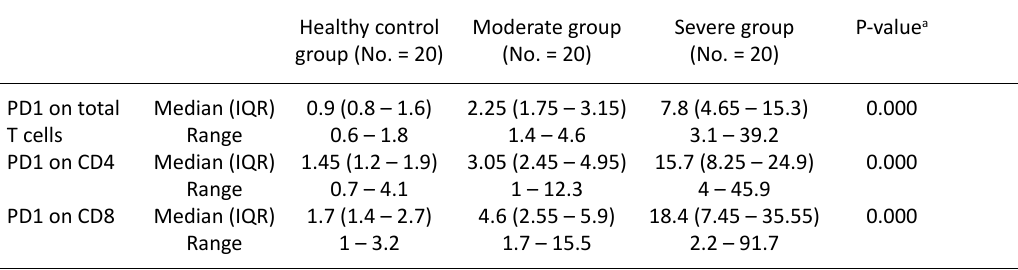
Fig. 1. Comparison between the healthy control group, moderate group and severe group regarding IL-10 serum level revealing a higher level in patient groups than in the control group. The used test for statistical analysis is the One Way ANOVA table 2. Comparison between the healthy control group, moderate group, and severe group regarding % PD1 expression